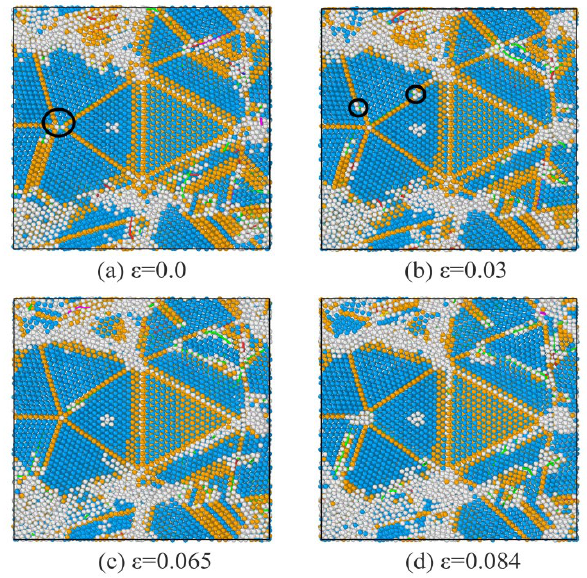
Figure 7. Slices of the evolution of dislocations in a defective penta-twinned region. FCC structures are colored blue, and HCP structures are colored orange, other atoms are colored gray. ( a ) ε = 0.0, ( b ) ε = 0.03, ( c ) ε = 0.065, ( d ) ε = 0.084.